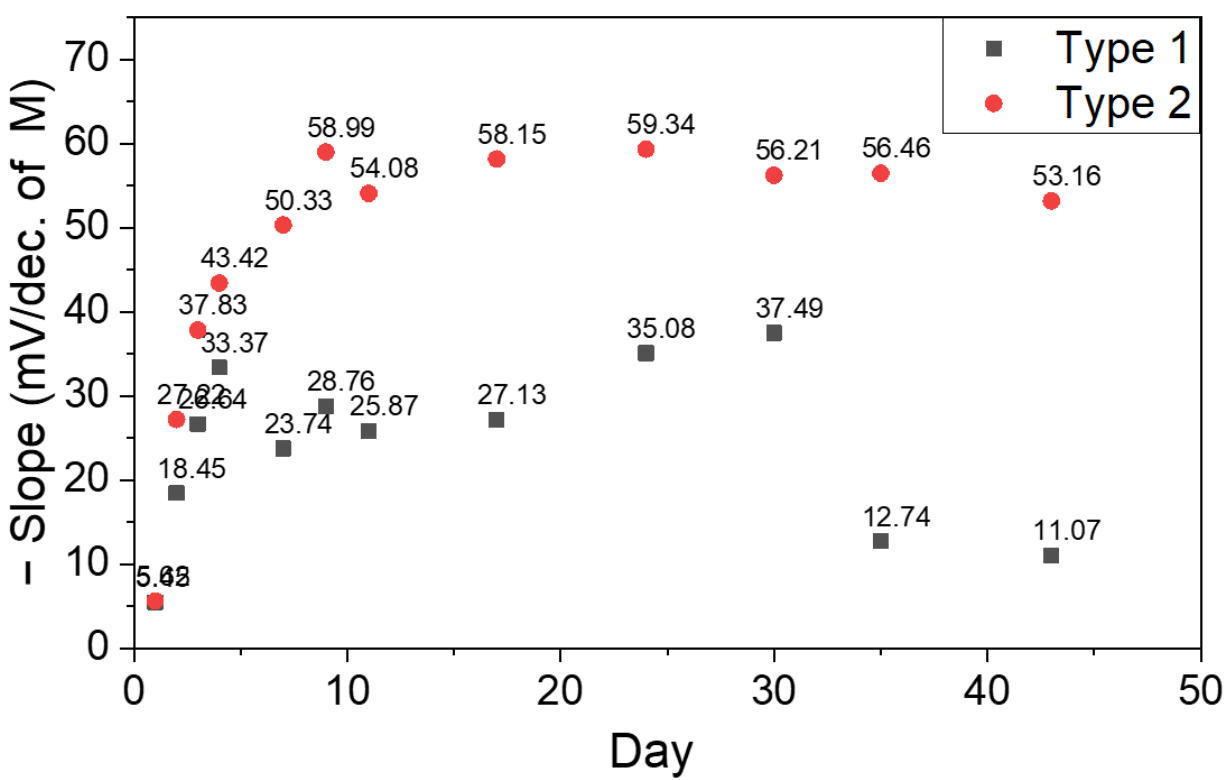
Figure 5. Durability measurements taken over a period of 43 days for Type 1 and Type 2 ISEs.